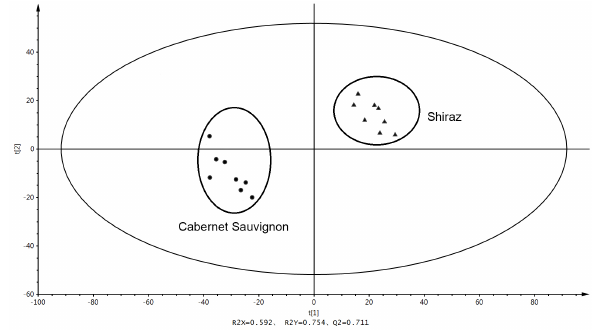
Figure 3: PLS-DA scores plot based on the 1 H NMR spectra of Cabernet Sauvignon and Shiraz dry red wines. Black solid circles and black solid triangles represent Cabernet Sauvignon and Shiraz dry red wines samples,